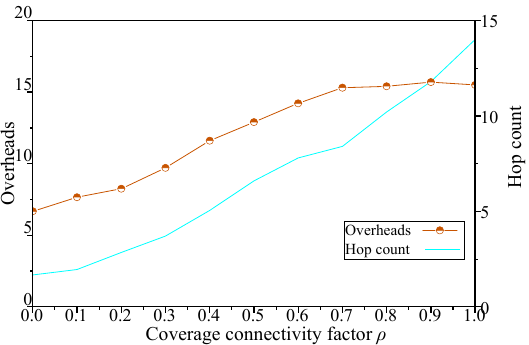
Figure 7. Influence of ρ on network overhead and hop count.